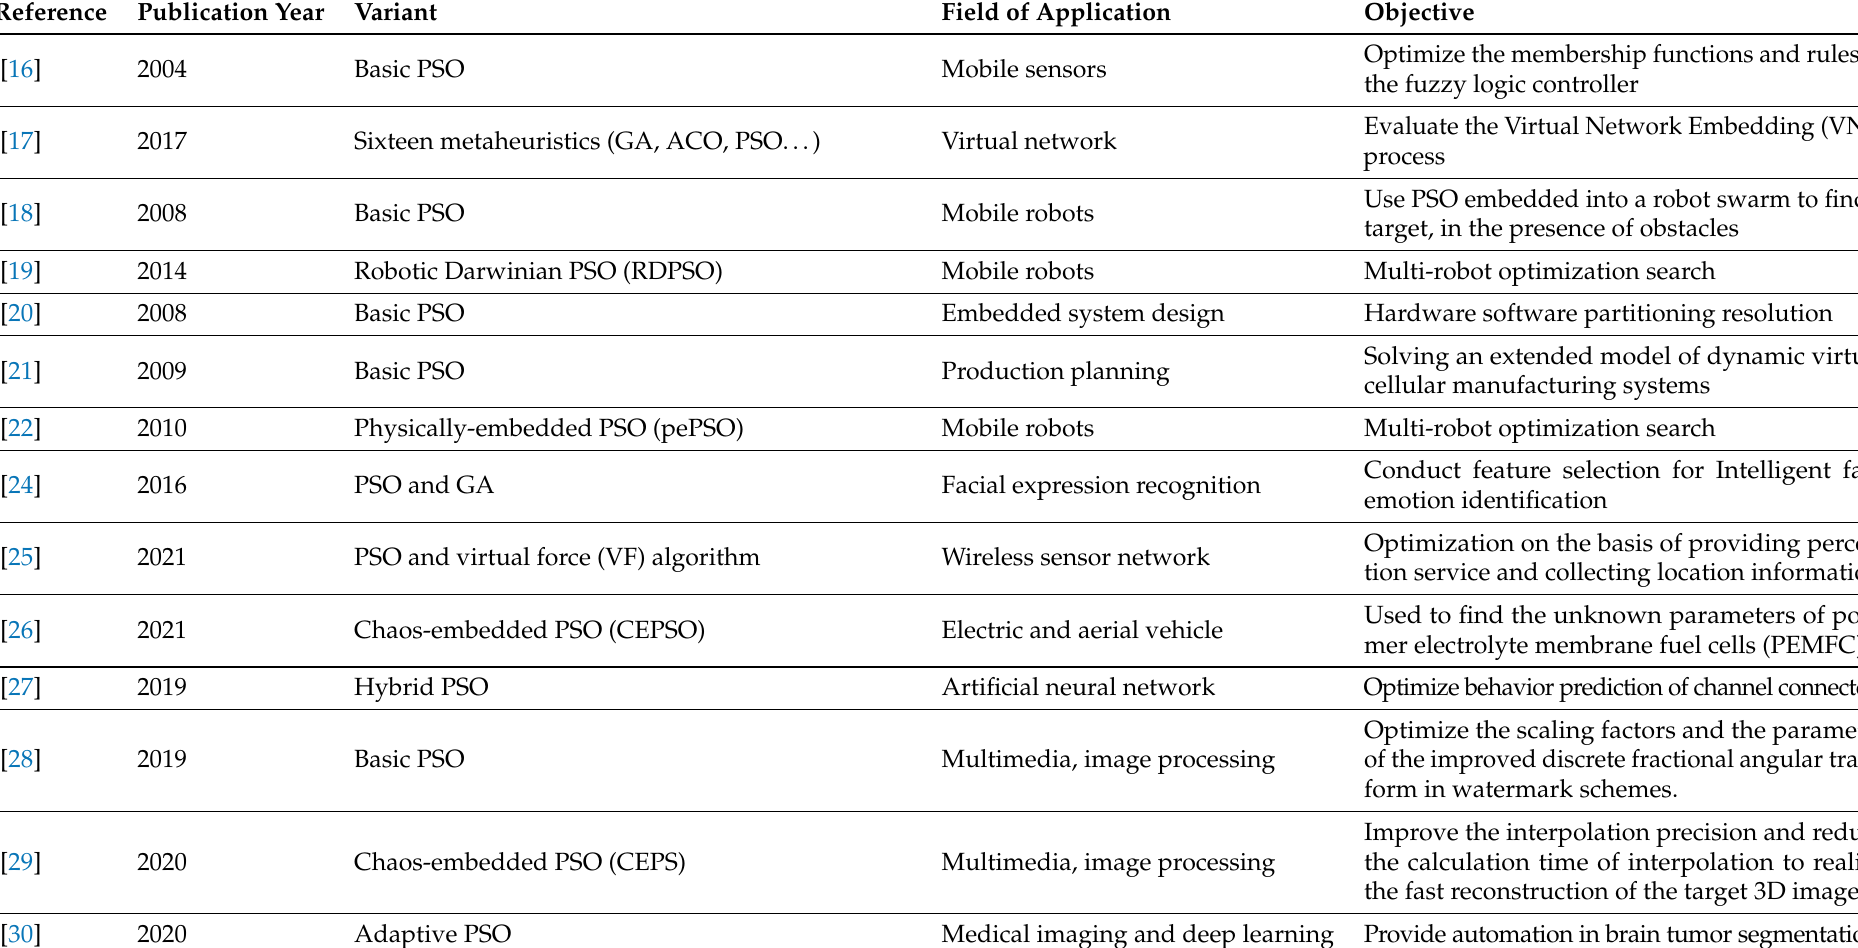
Table 1. Previous embedded particle swarm optimization (PSO)